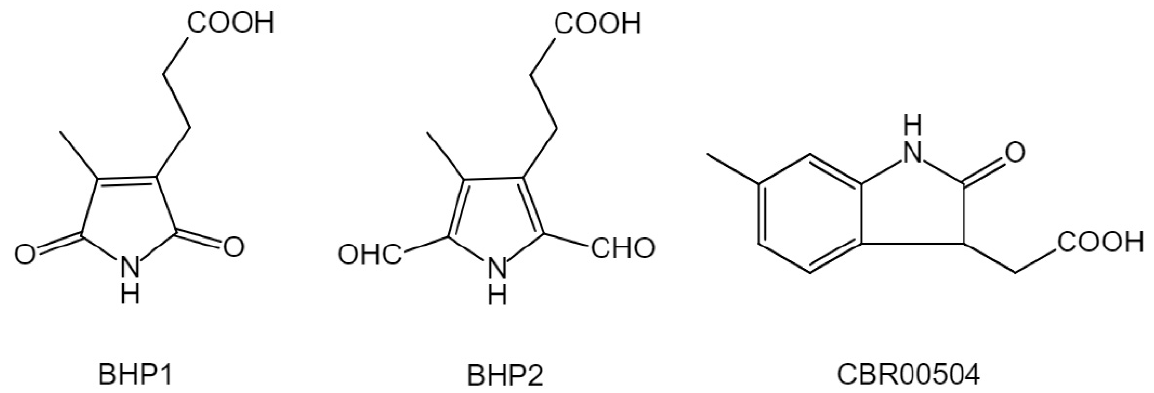
Scheme 2. The structures of BHP1, BHP2, and CBR00504 (used as the internal standard for quantita- tion by LC-MS/MS). The high-resolution ESI − mass spectrum of BHP2 exhibited the deprotonated molec- ular ion at m / z 208.0618 (Figure S3); thus, the molecular formula was determined as C 10 H 11 NO 4 (the calculated m / z for the deprotonated molecular ion was 208.0610). The 1 H NMR spectrum in DMSO- d 6 (Figure S4) showed the signals of nine protons. Among them, the signals of two protons appeared at 9.829 and 9.834 ppm (Figure S5), which were on carbons with the chemical shifts at 182.7 ppm as determined by the HMQC spec- trum (Figure S6). Apparently, they were the signals of two formyl groups. The spectra, together with the correlation spectroscopy (COSY) spectrum (Figure S7), also indicated the presence of a methyl group (2.27 ppm) and a -CH 2 CH 2 - moiety (2.43 and 2.92 ppm). The heteronuclear shift correlations via the multiple bond connectivity (HMBC) spectrum (Figure S8) showed that the protons on the formyl and methyl groups, and a methylene group (at 2.92 ppm), were all coupled to two carbons at 127.5 and 132.5 ppm, providing evidence that these groups were attached to a pyrrole ring. Collectively, the structure of BHP2 was characterized as 2,5-diformyl-4-methyl-1 H -pyrrole-3-propanoic acid (Scheme